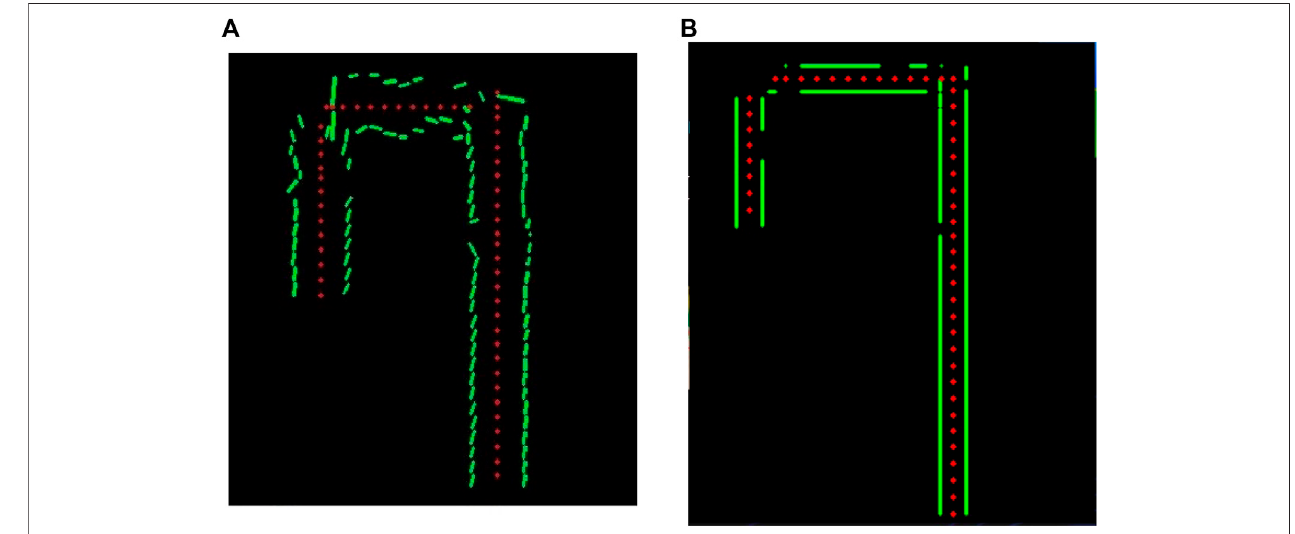
FIGURE 5 | Sketch adjustment. (A) Map before adjustment. (B) Adjusted map.